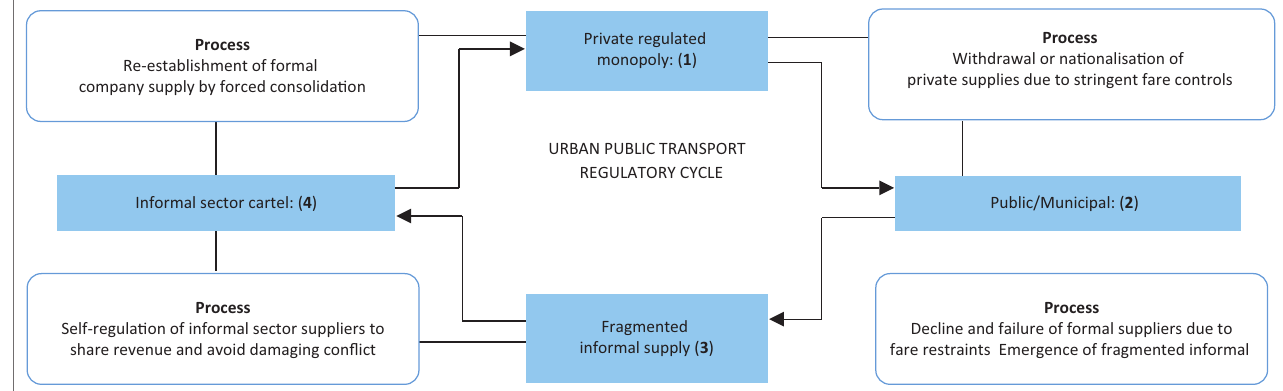
FIGURE 4: The post-colonial regulatory